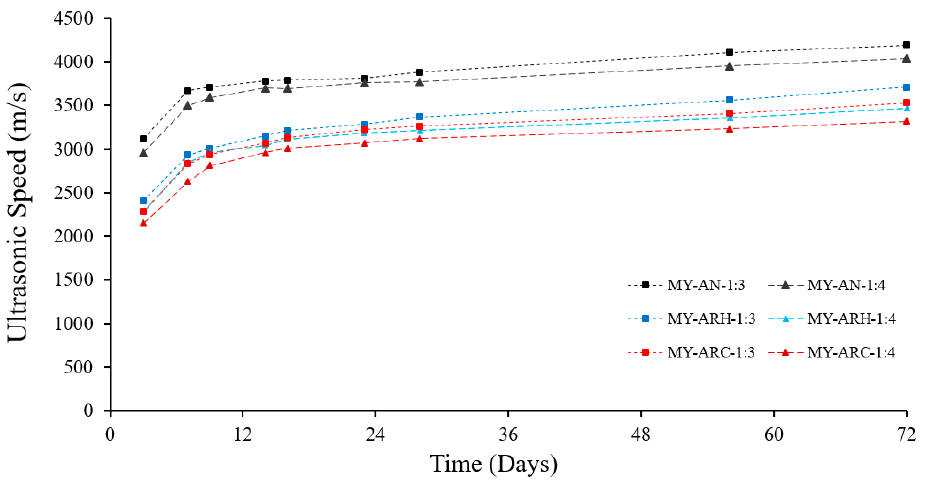
Figure 5 . Variation of the propagation speed of ultrasound (m/s) versus time (days) for the prepared Figure 5. Variation of the propagation speed of ultrasound (m / s) versus time (days) for the prepared mortar specimens. mortar specimens.